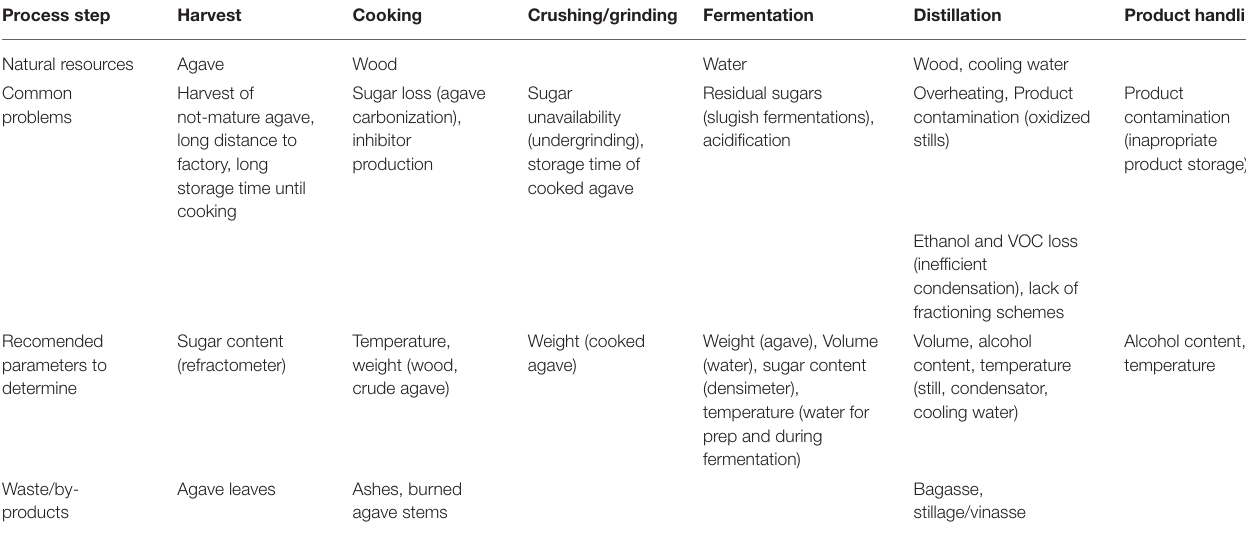
TABLE 6 | Common problems encountered and recommended parameters to determine during mezcal production